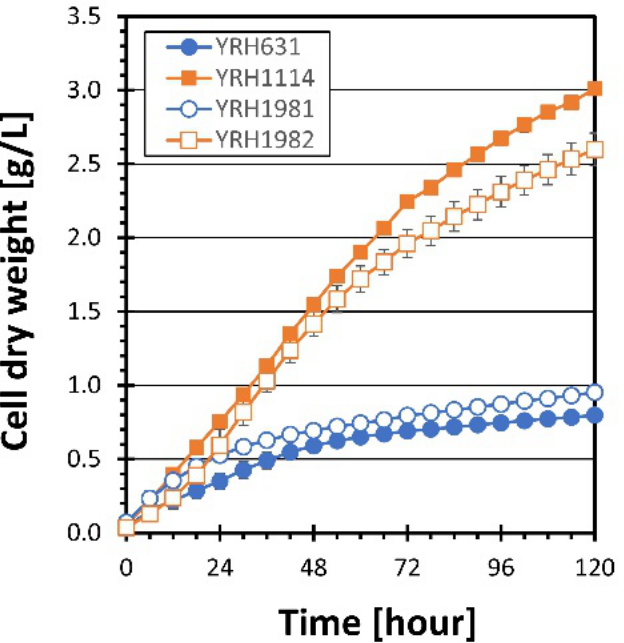
Figure 2. Comparison of growth on xylose medium. Homozygous diploid (YRH1982 ) and heterozygous diploid (YRH1981 ) strains were grown on YP medium + 50 g/L xylose and com- pared to the unadapted haploid (YRH631 ) and adapted haploid (YRH1114 ) strains. Cell dry weight was used to measure cell mass instead of OD 600 to account for differences in dry weight per OD 600 between haploid and diploid strains. Plots are the average values from at least triplicate cultures. Error bars show standard deviations.